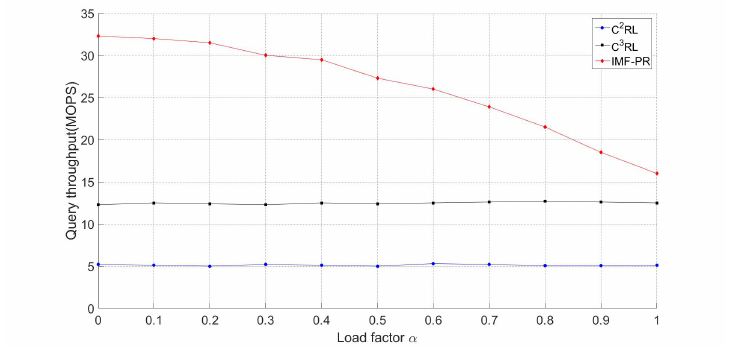
Figure 12. Query